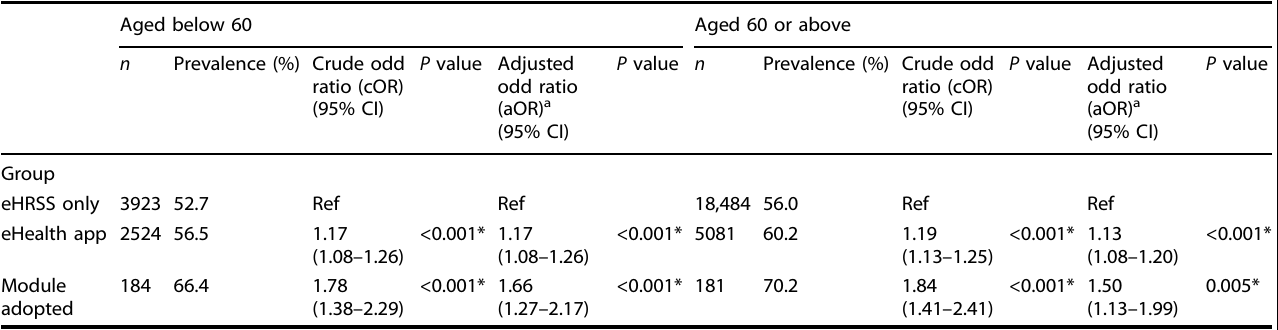
Table 4. Factors associated with optimal control of HbA1c in females aged 60 years and